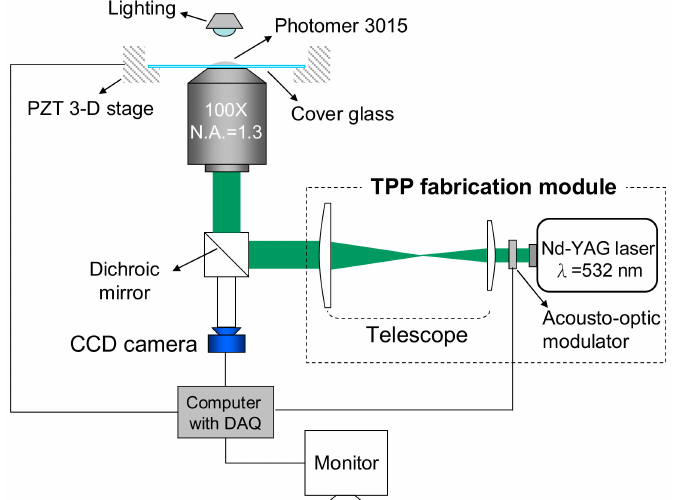
Figure 1. Schematic set up for two-photon polymerization (TPP) fabrication: The commercial resin (Photomer 3015) with 0.3% of photo-initiator is placed on a cover slip. The TPP fabrication module generates laser pulses of duration 0.55 ns at a 12 kHz repetition rate from a 532 nm Nd:YAG microchip laser. The laser energy was focused into the resin using an oil immersion 100 × objective microscope. The cover slip is moved with a nano-positioning stage to allow the focal point to traverse any designated